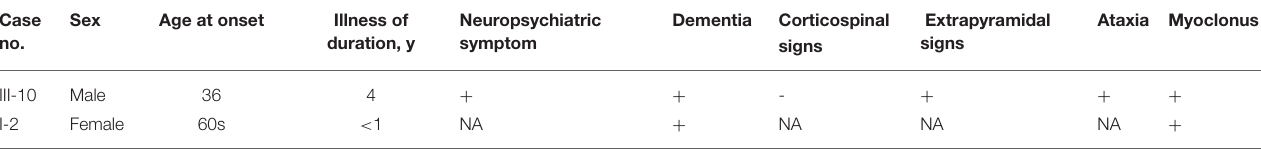
TABLE 2 | Summary of clinical features in affected family members. Case no.